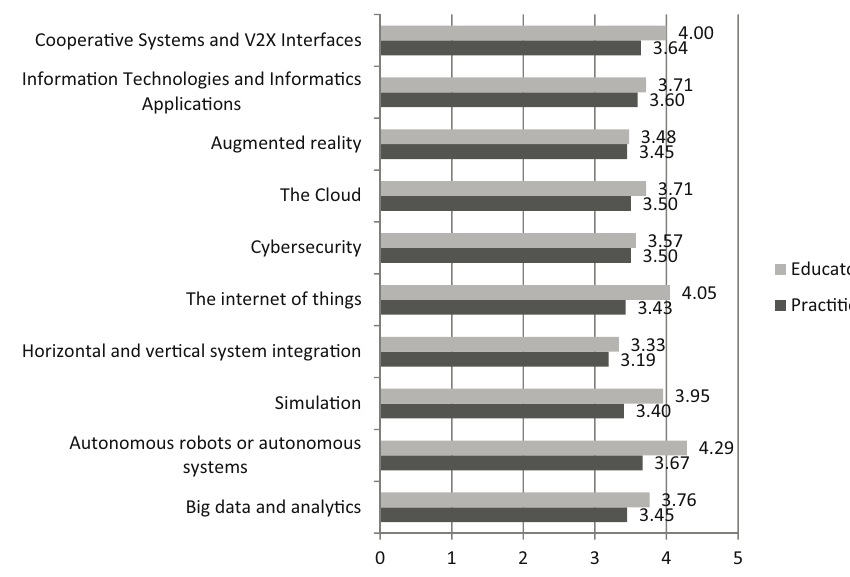
Figure 1: Technical competences in the opinion of practitioners and educators. Source: author ’ s own study.